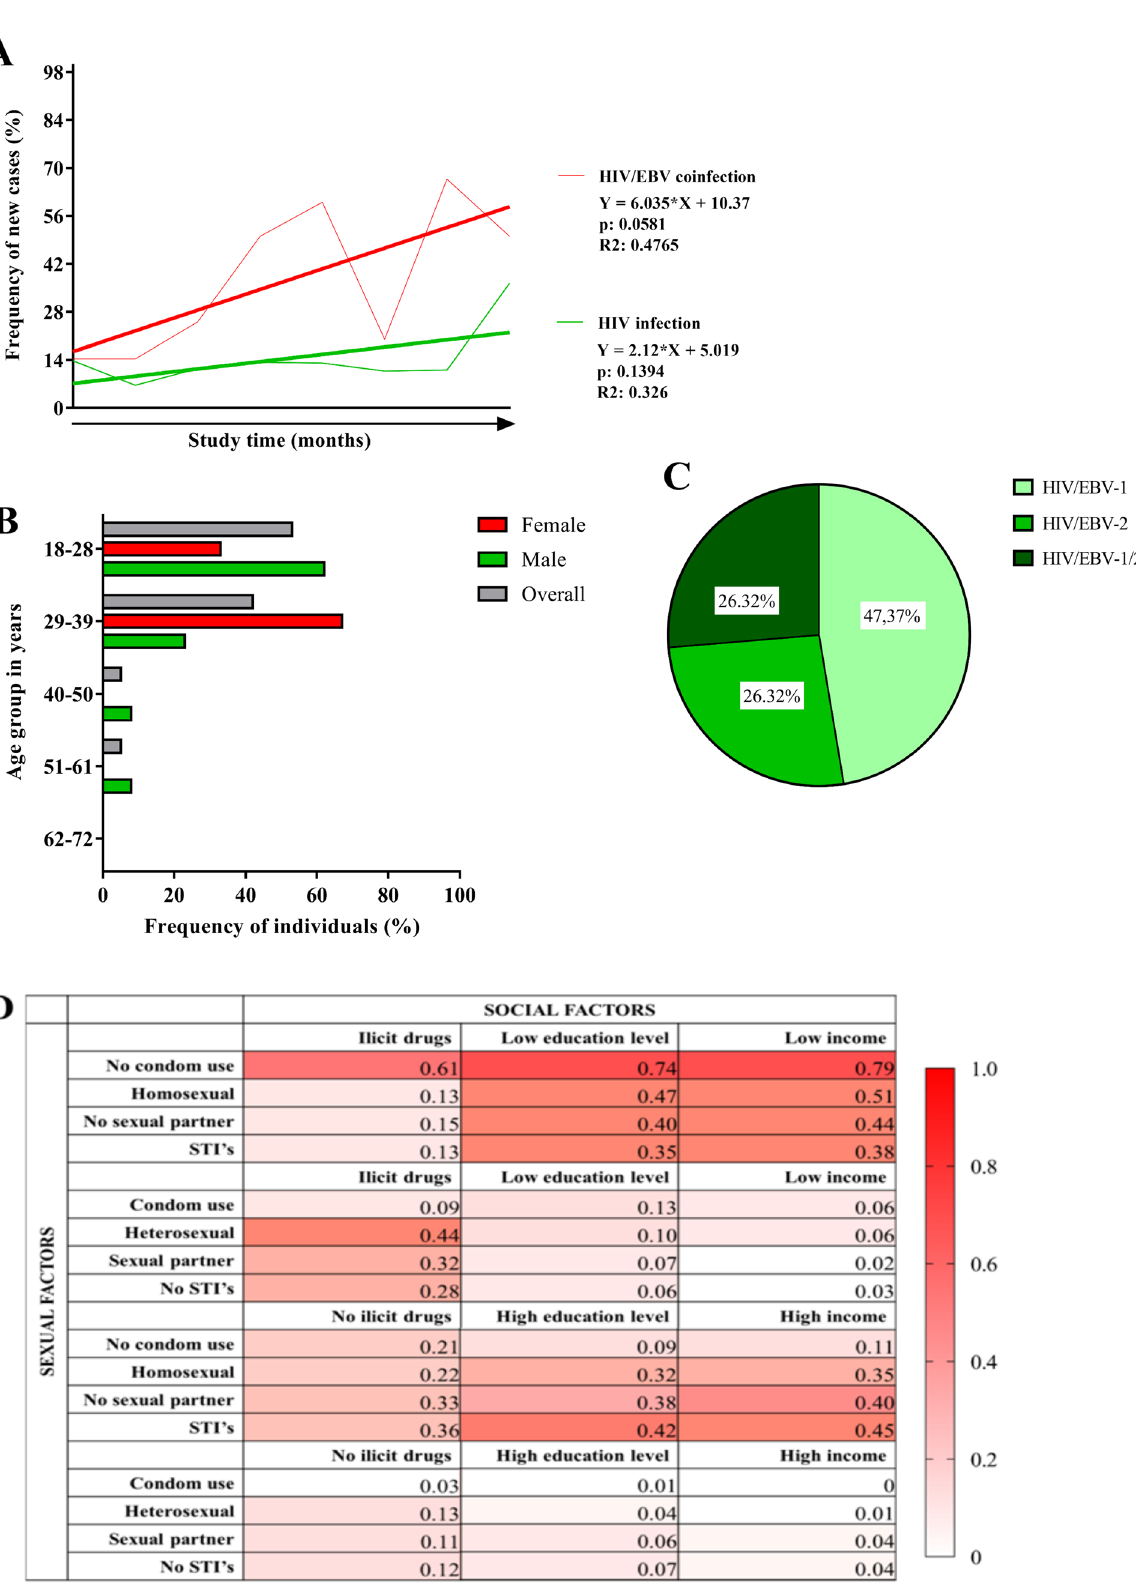
Figure 1. Frequency of cases and degree of exposure: ( A ) Frequency of new cases of HAART-free HIV-1 patients coinfected with HIV/EBV in the period between January 2018 and December 2019. ( B ) Prevalence of cases of HIV/EBV coinfection stratified based on age and sex. ( C ) Prevalence of EBV genotypes among HIV/EBV coinfected patients. ( D ) Potential risk/exposure to HIV-1 monoinfection or co-infection. The color gradient was proposed based on data on the frequency of individuals screened according to the intersection of social and sexual